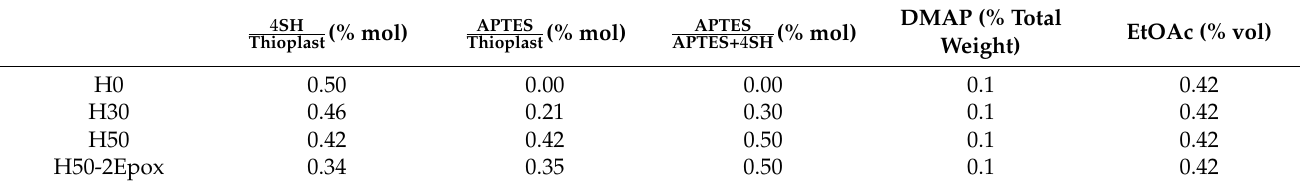
Table 1. Crosslinker molar ratios of the four tested materials.